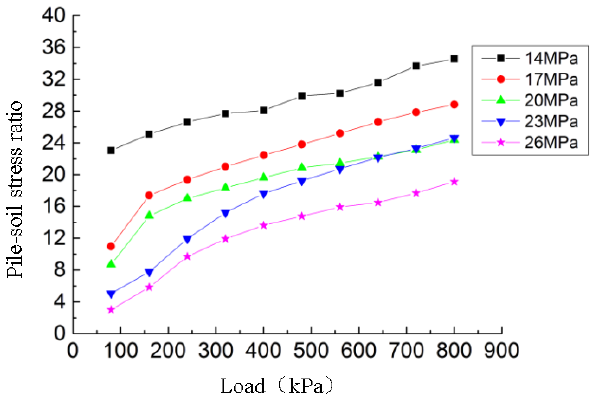
Figure 23. The elastic modulus of the soil effect on the pile-soil ratio.